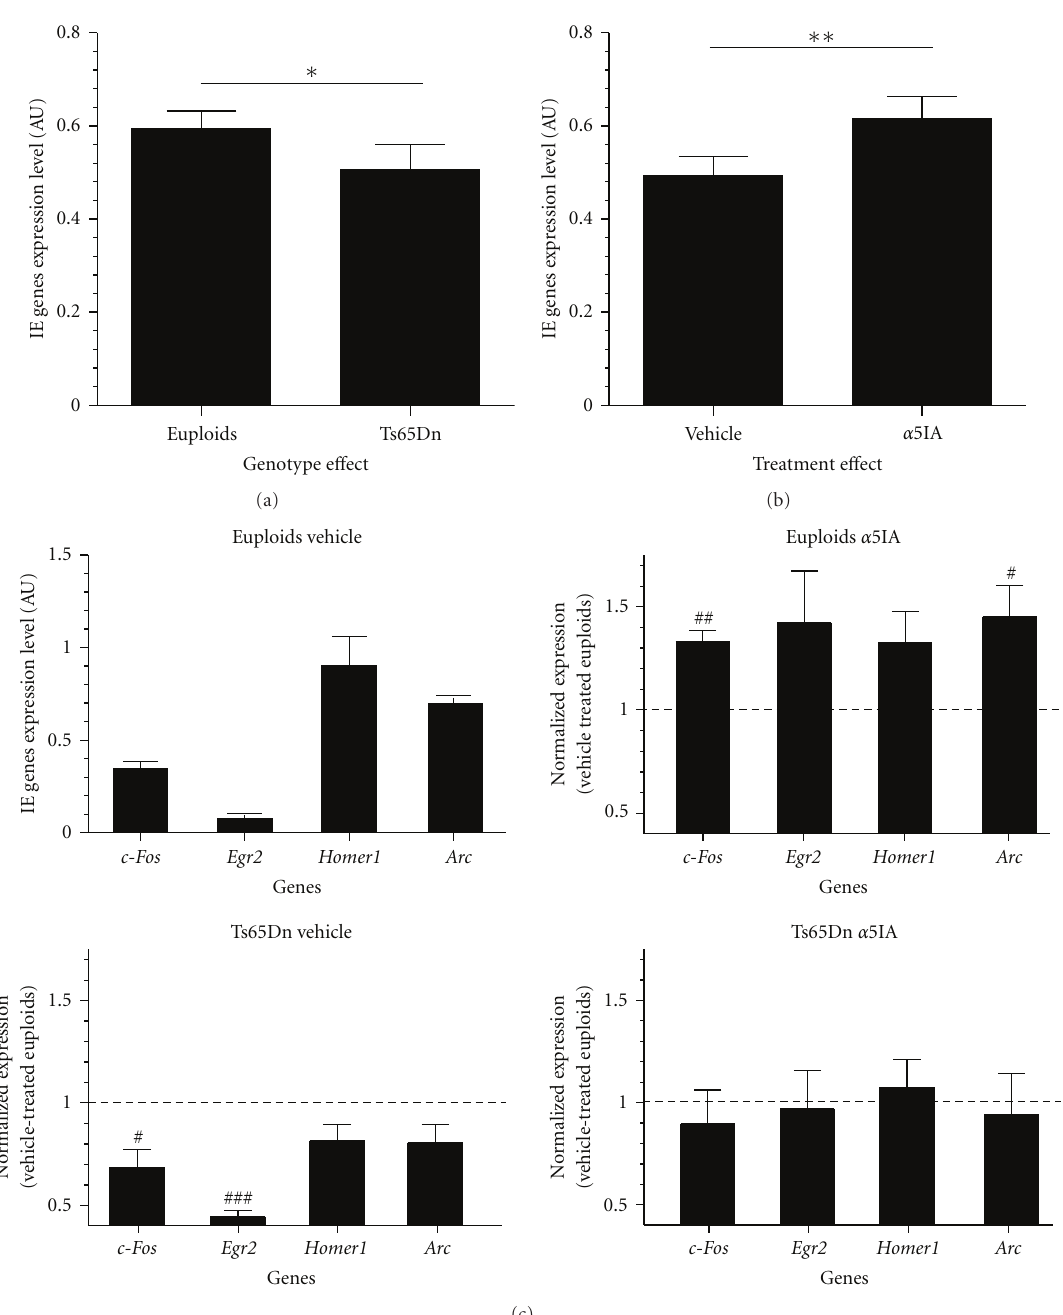
Figure 6: QPCR expression level of selected IEGs. (a) Mean cumulated expression levels of five selected IEGs in euploid and Ts65Dn mice; (b) e ff ect of α 5IA treatment on the mean level of expression of five selected IEGs; (c) expression of c-Fos, Egr2, Bdnf, Homer-1, and Arc in the four genotype and treatment experimental groups. ∗ P < . 05, two-way ANOVA with Fisher’s post hoc comparisons; # P < . 05, ### P < . 001, and one-sample t